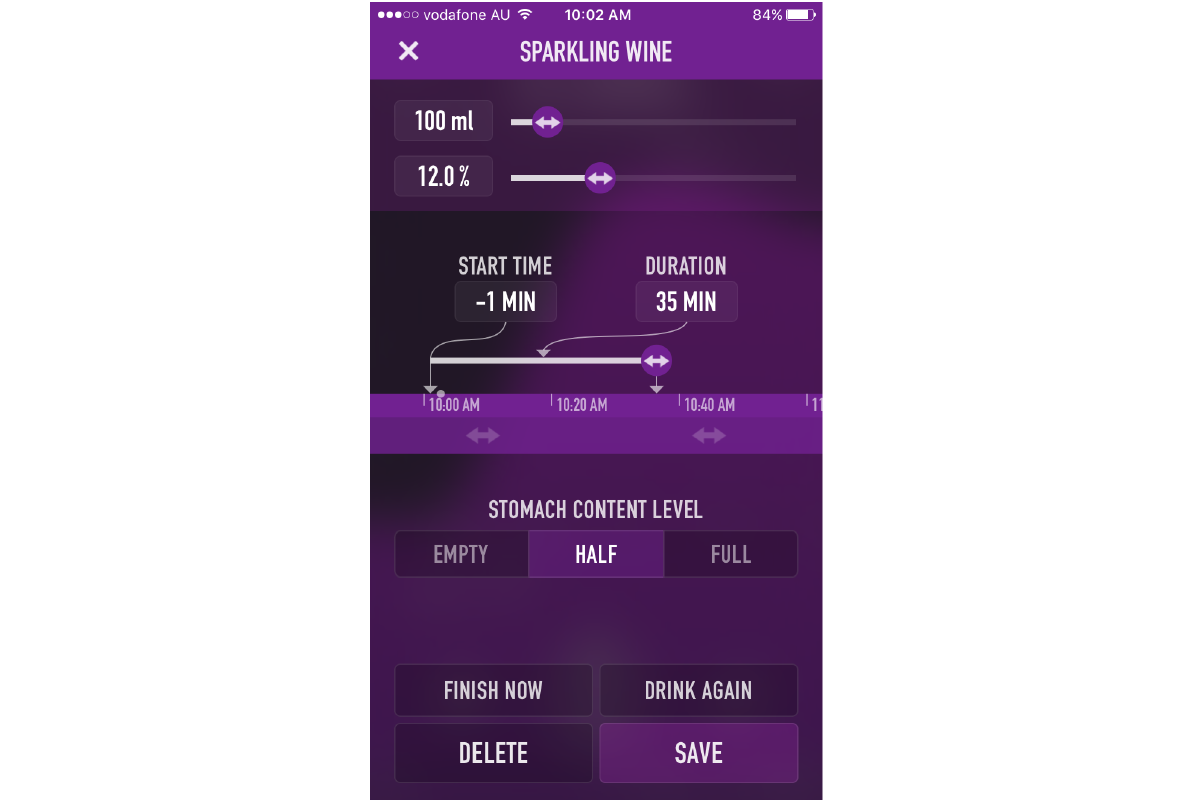
Figure 5. IntelliDrink Screenshot